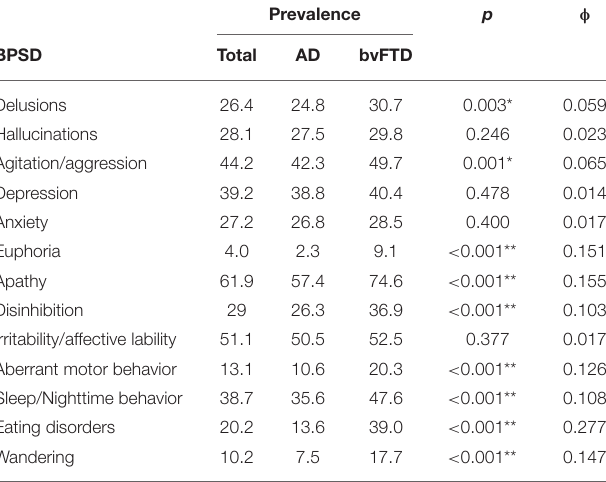
TABLE 2 | Prevalence of BPSD in the whole sample and in AD and bvFTD groups. Prevalence